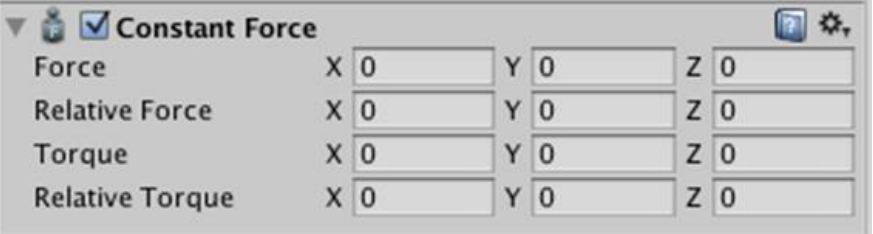
Figure 21. Wind direction changes during simulation.